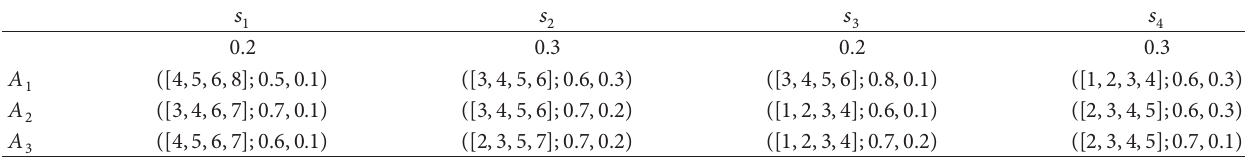
Table 2: Prospect information for attribute 𝑐 2 .